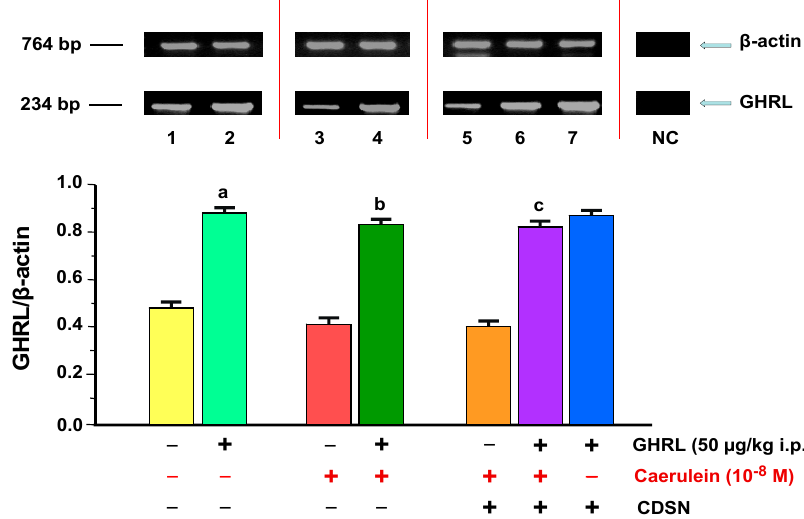
Figure 3. Analysis of ghrelin (GHRL) gene expression determined by reverse transcriptase-polymerase chain reaction (RT-PCR) and densitometric analysis of GHRL/ β -actin mRNA ratio in pancreatic acinar cells: (line 1) acinar cells obtained from control sensory nerves (SN)-intact rats treated with saline, after isolation, acinar cells incubated in caerulein-free solution; (line 2) acinar cells obtained from SN-intact rats treated with GHRL, after isolation, acinar cells incubated in caerulein-free solution; (line 3) acinar cells obtained from SN-intact rats treated with saline, after isolation, acinar cells incubated in solution containing caerulein at a concentration of 10 − 8 M; (line 4) acinar cells obtained from SN-intact rats treated with GHRL, after isolation, acinar cells incubated in solution containing caerulein at a concentration of 10 − 8 M; (line 5) acinar cells obtained from rats with capsaicin deactivation of SN (CDSN) and treated with saline, after isolation, acinar cells incubated in solution containing caerulein at a concentration of 10 − 8 M; (line 6) acinar cells obtained from rats with CDSN and treated with GHRL, after isolation, acinar cells incubated in solution containing caerulein at a concentration of 10 − 8 M; (line 7) acinar cells obtained from rats with CDSN and treated with GHRL, after isolation, acinar cells incubated in caerulein-free solution. NC = negative control. Reference gene: β -actin. a p < 0.05 compared to control acinar cells obtained from rats with intact SN (line 1); b p < 0.05 compared to acinar cells stimulated with caerulein after isolation from SN-intact rats treated with saline (line 3); c p < 0.05 compared to acinar cells stimulated with caerulein after isolation from rats with CDSN and treated with saline (line 5). In each experimental group, the number of observations was at least 6.